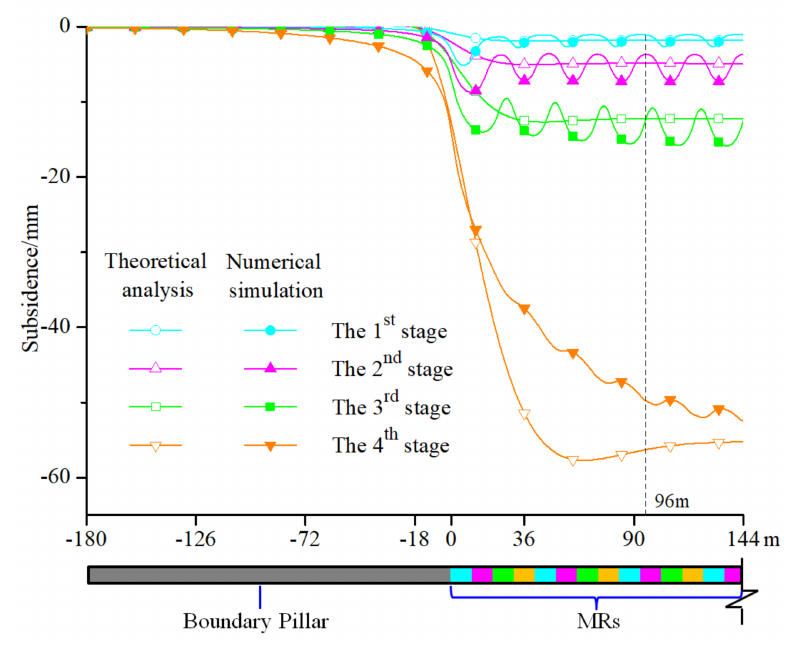
Figure 12. The subsidence amount of the roof center line along the strike